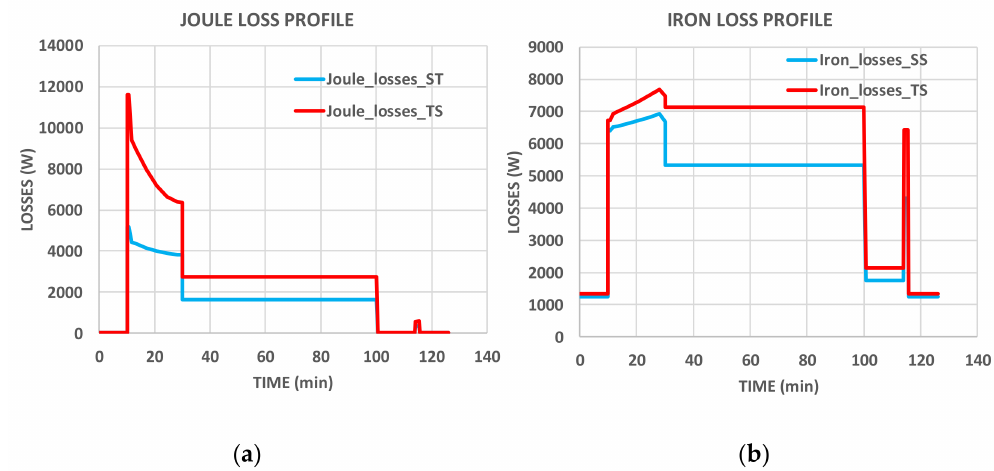
Figure 16. Motor loss profiles (blue: steady-state (SS) optimization, red: transient state (TS)). ( a ) Joule losses, and ( b ) iron Losses.